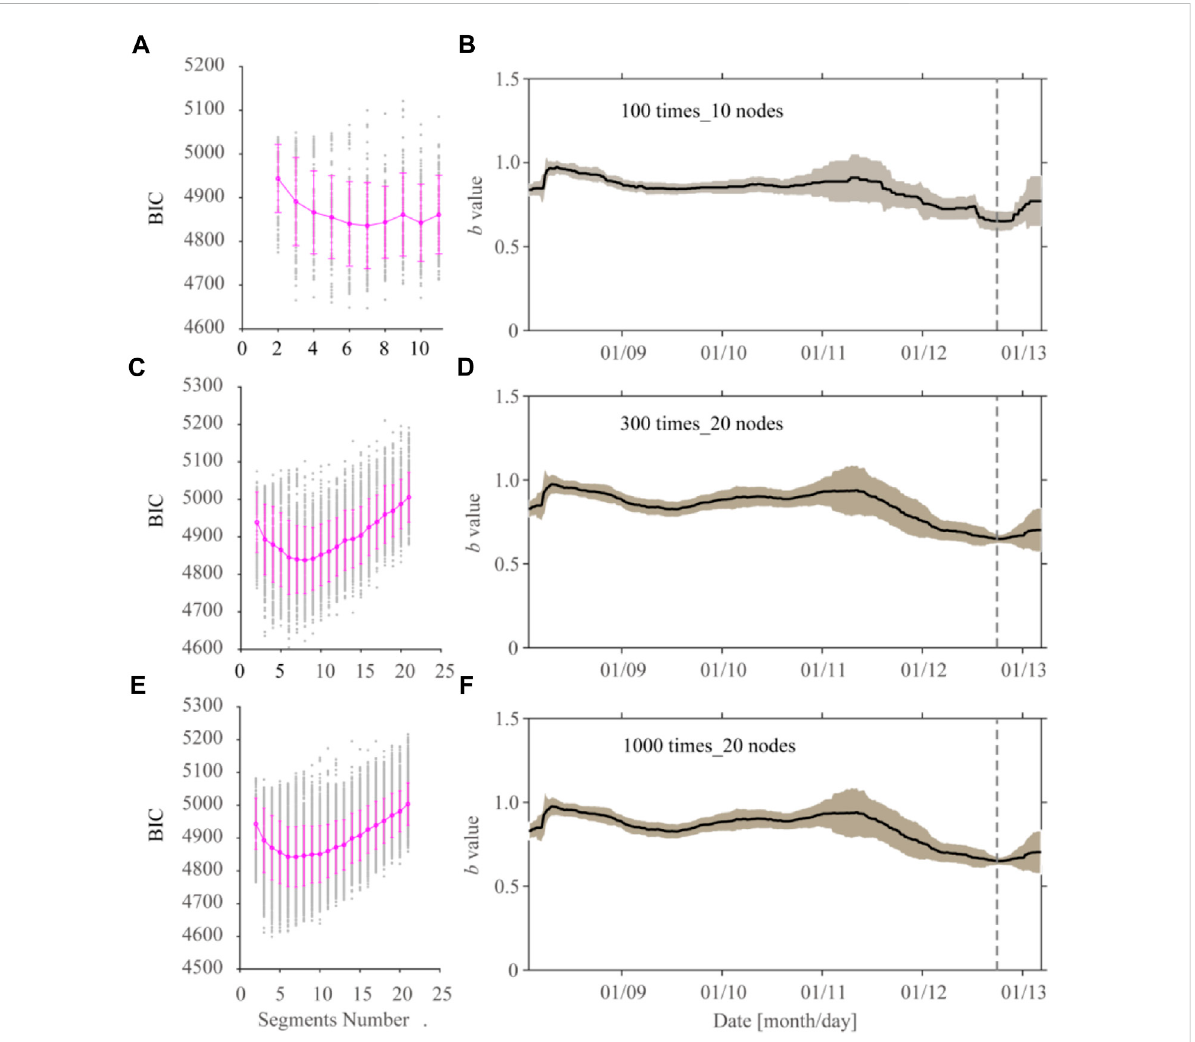
FIGURE 4 TbDD method calculation results for the 8 January 2022 Menyuan M S 6.9 earthquake sequence. (A,C,E) BIC value distribution under different partitionperiods.ThegraydotsdenotethecalculationresultsofBICvalues,andthepinkdotsandverticallinesdenotethecorrespondingmeansand standard deviations of the BIC values, respectively. (B,D,F) Time-sequence changes of b- values calculated by TbDD. The black curves indicate the ensemble medians of b- values, the gray areas indicate the MAD of corresponding b- values, and the gray vertical dotted lines show the time of occurrence of strong aftershocks of the Menyuan M S 5.2 aftershock on 12 January